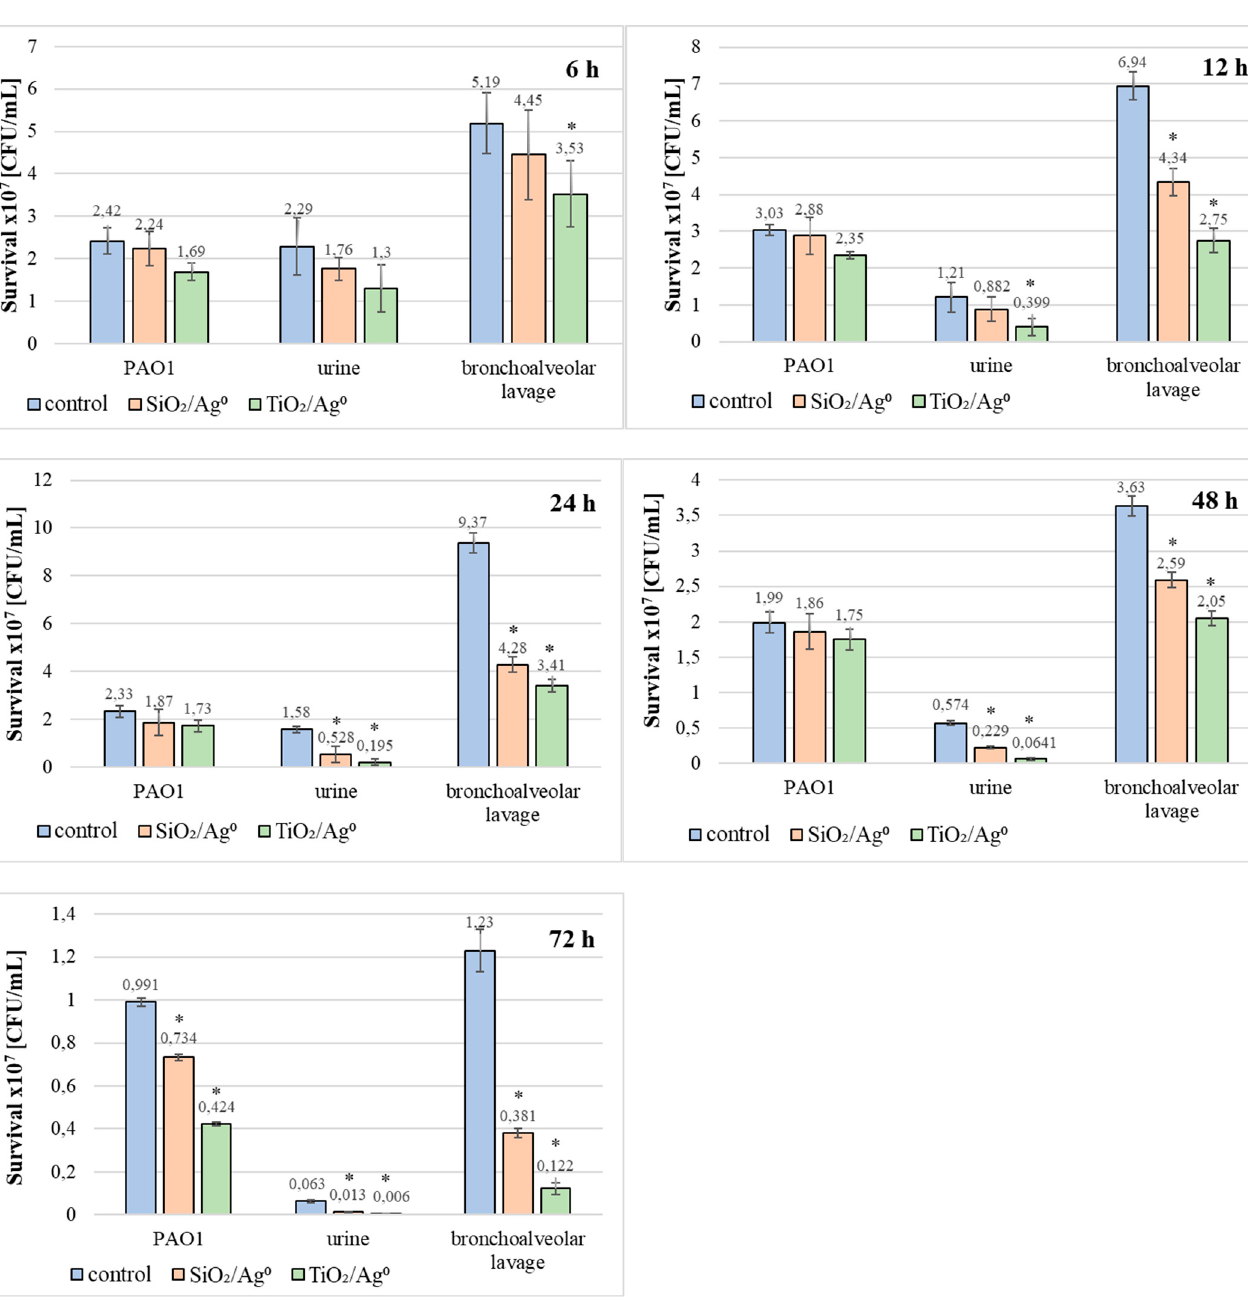
Figure 9. Effect of SiO 2 /Ag 0 and TiO 2 /Ag 0 at a concentration of 0.5 × MBIC on survival PAO1 and clinical strains of P. aeruginosa in biofilms. Values represent the mean ±SD for five strains isolated from urine and five from bronchoalveolar lavage fluid. * p ≤ 0.05 compared with